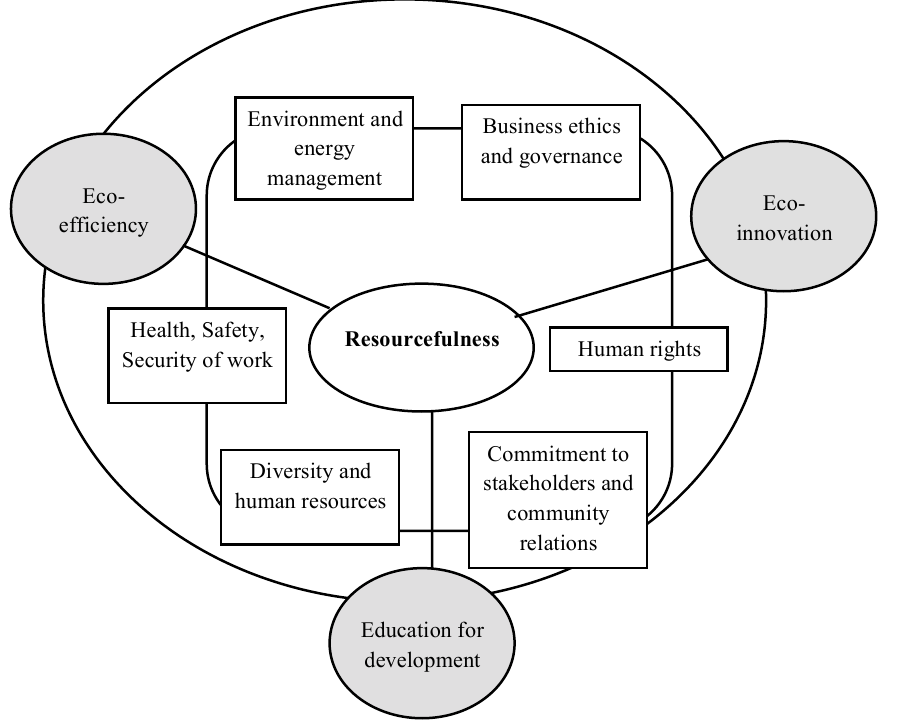
Figure 1: Key Areas and Topics of OMV Petrom Social Responsibility